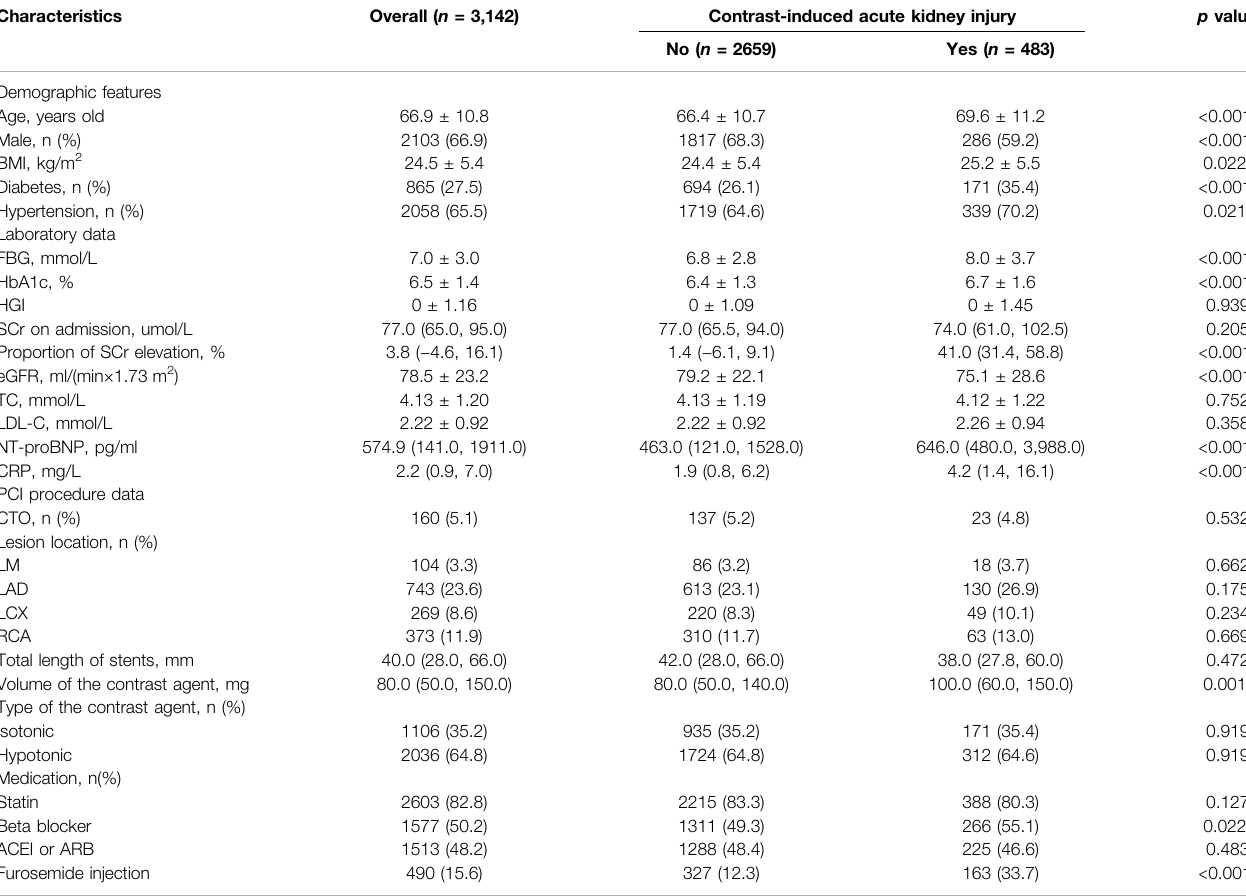
TABLE 1 | Descriptive statistics for baseline characteristics of patients with/without CI-AKI.